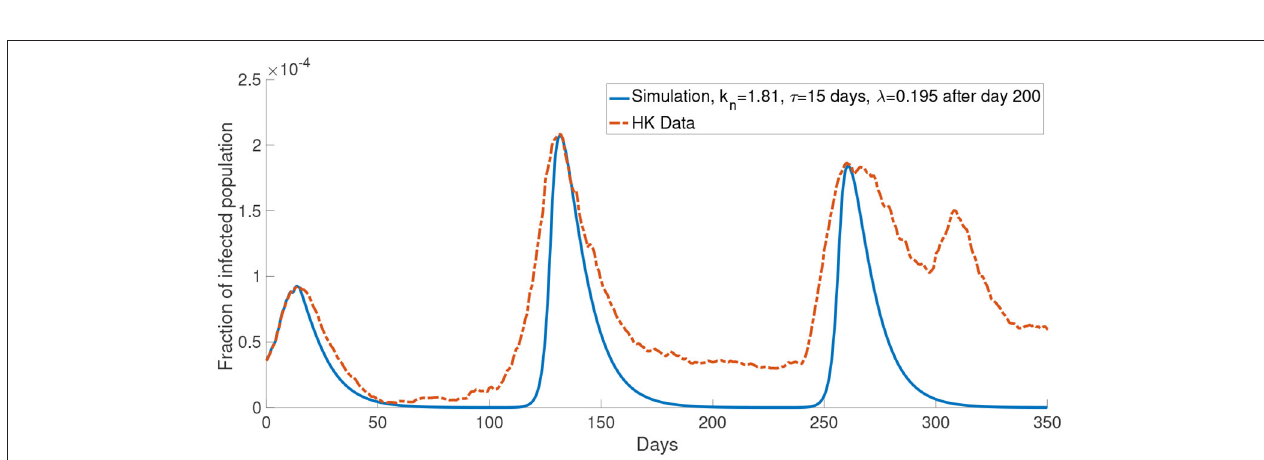
FIGURE 11 | The comparison of the data and the simulation for the system with M = 2 with λ increased to 0.195 after day 200.